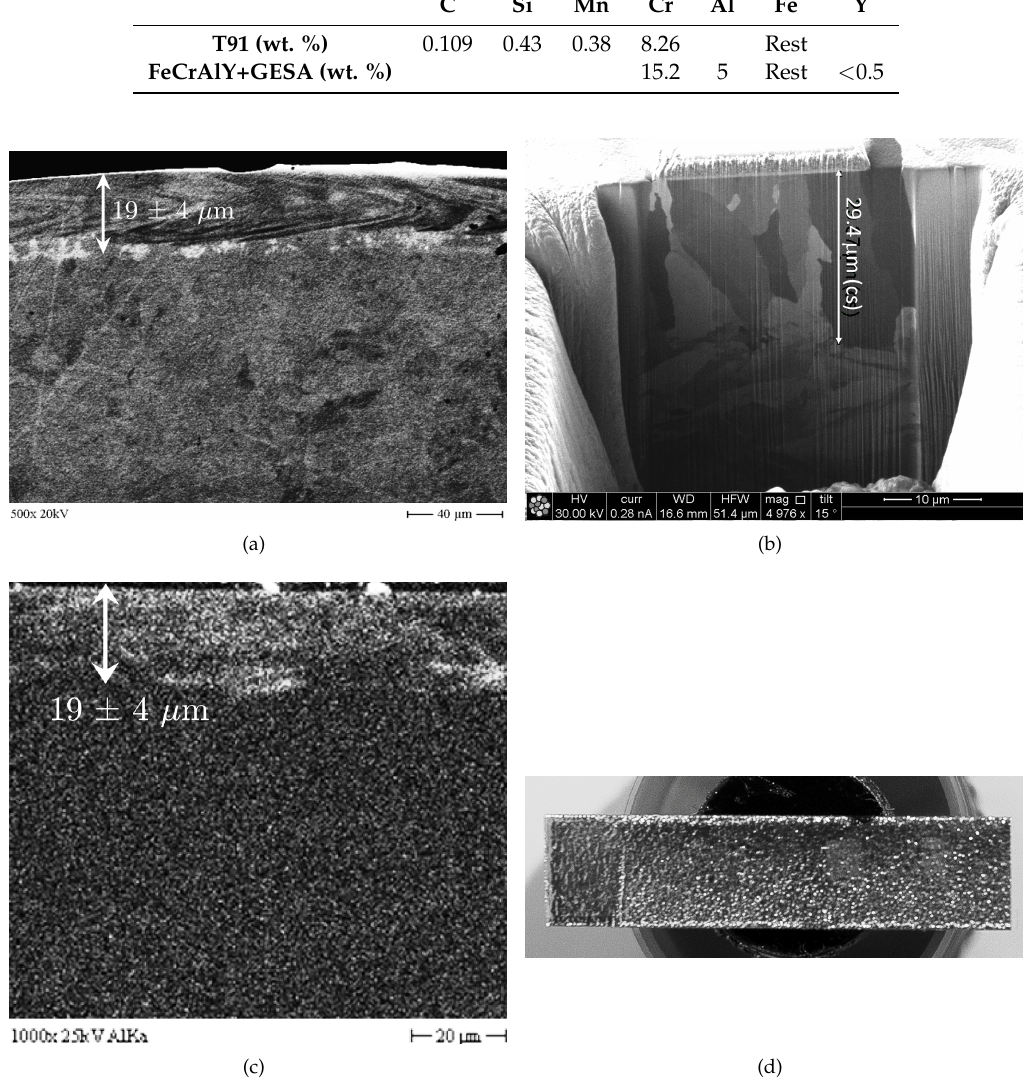
Figure 1. ( a ) SEM image of a polished cross-cut of an AlFeCr alloy/T91 steel sample showing the coating-substrate interface with a coating thickness of ∼ 19 µ m. ( b ) SEM picture of FIB cut cross section of the sample reveals a gradient in the phase domain sizes along the depth direction, extending to 30 µ m in depth. ( c ) Aluminum enrichment in the coating layer as measured by the XEDS technique. Bright regions correspond to a larger aluminum content. ( d ) Photograph of the sample, depicting the macroscopic surface